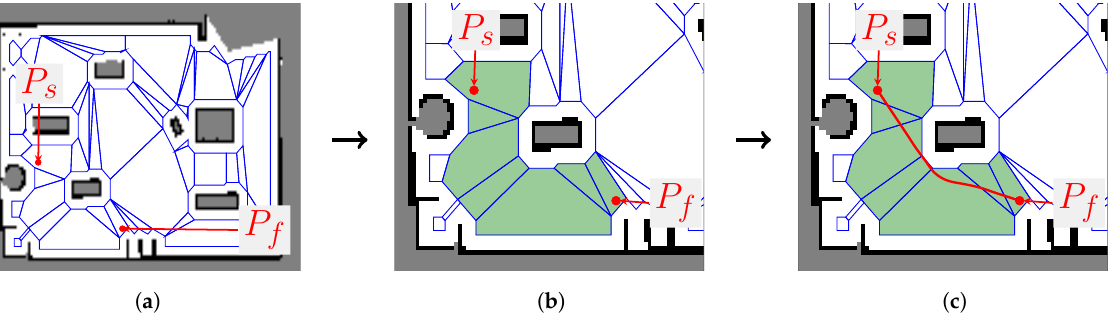
Figure 7. Main tasks of the Navigation with Polytopes toolbox. ( a ) Polytope map from a grid map; ( b ) finding a sequence of polytopes; ( c ) planning a B-spline reference